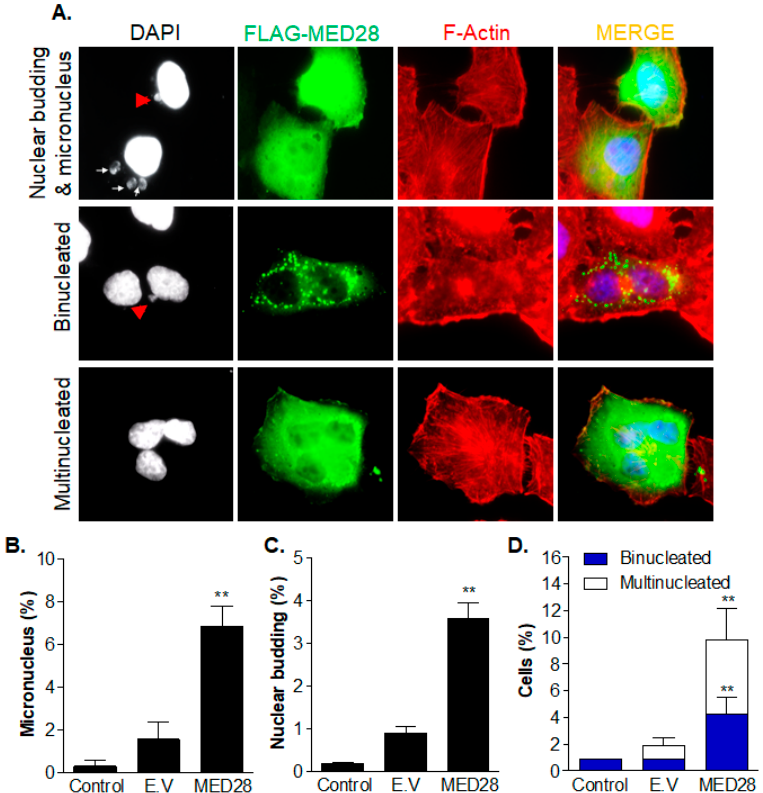
Figure 5. Overexpression of MED28 induces genomic instability and aneuploidy. ( A ) Anti-Flag (green) and anti-F-actin (red) immunostaining of HeLa cells transfected with the Flag-MED28 construct. 4 ′ ,6-Diamidino-2-phenylindole (DAPI) was used for nuclear staining. The white arrow and red arrowhead indicate a micronucleus and nuclear budding, respectively. Fluorescence images were captured by confocal microscopy under 60× magnification. ( B – D ) The micronuclei, nuclear budding, binucleated cells, and multinucleated cells were counted in control, empty vector (E.V.)-transfected, and MED28-expressing HeLa cells. The results are shown as mean ± SD from at least three independent experiments ( n = 4) (**, vs. E.V.). ** p < 0.01.